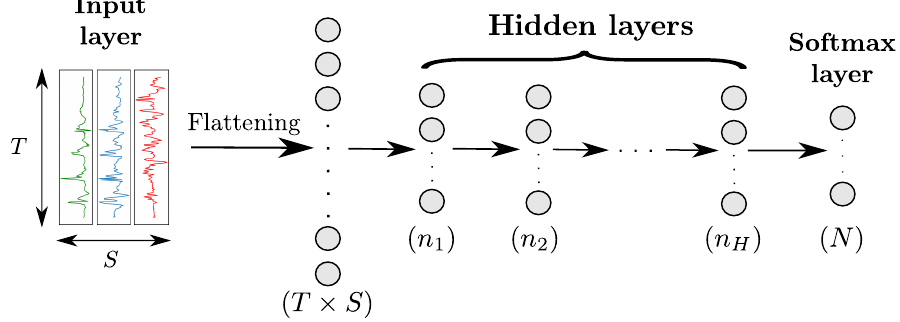
Figure 3. Architecture of a MLP model with H hidden layers for sensor-based HAR. Input data from the different sensor channels are first flattened into a ( T × S ) -dimensional vector and then fed to the hidden layers. All layers are fully-connected. The numbers in parenthesis indicate the number of neurons per layer. T , S and N designate the time length of the input data, the number of sensor channels, and the number of classes,